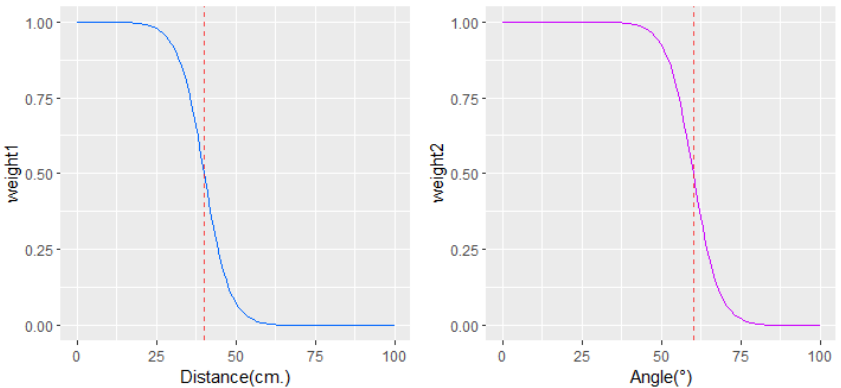
Figure 3. Weighting function based on distance and camera angles to combine information from multiple thermal images. Weights are inversely associated to distance and angle via inverse logistic function to set high weights to measurements obtained from distances smaller than 40 cm and angles below 60°.